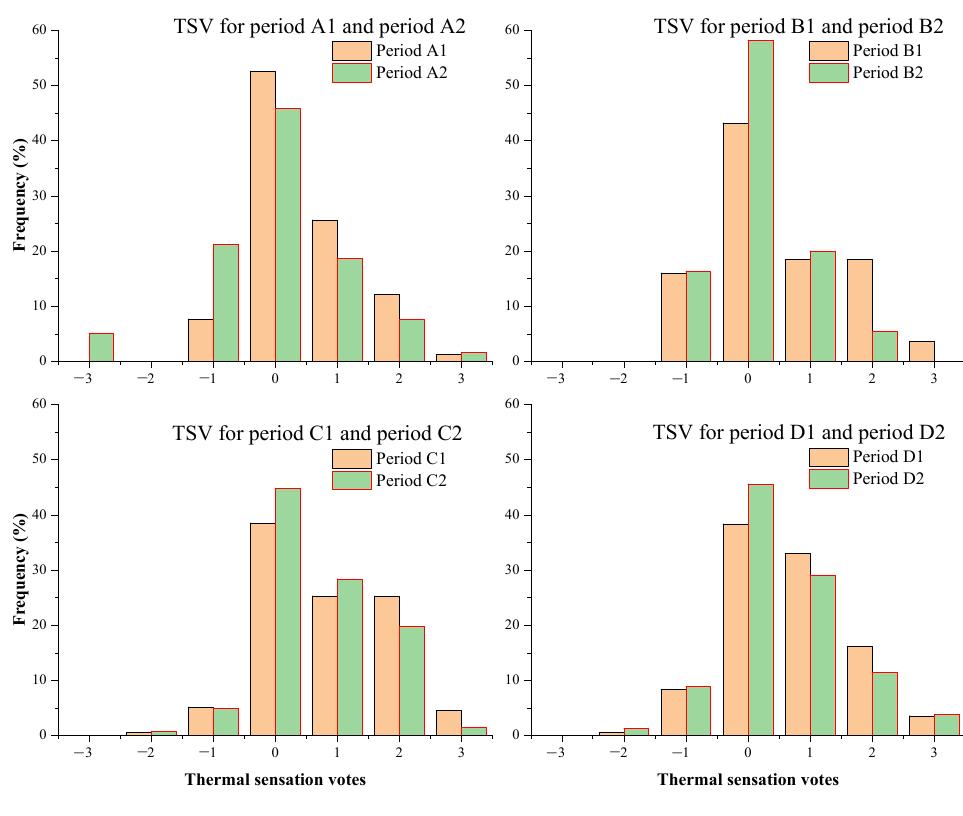
Figure 8. Thermal sensation votes. Table 6. Mean values of subjective